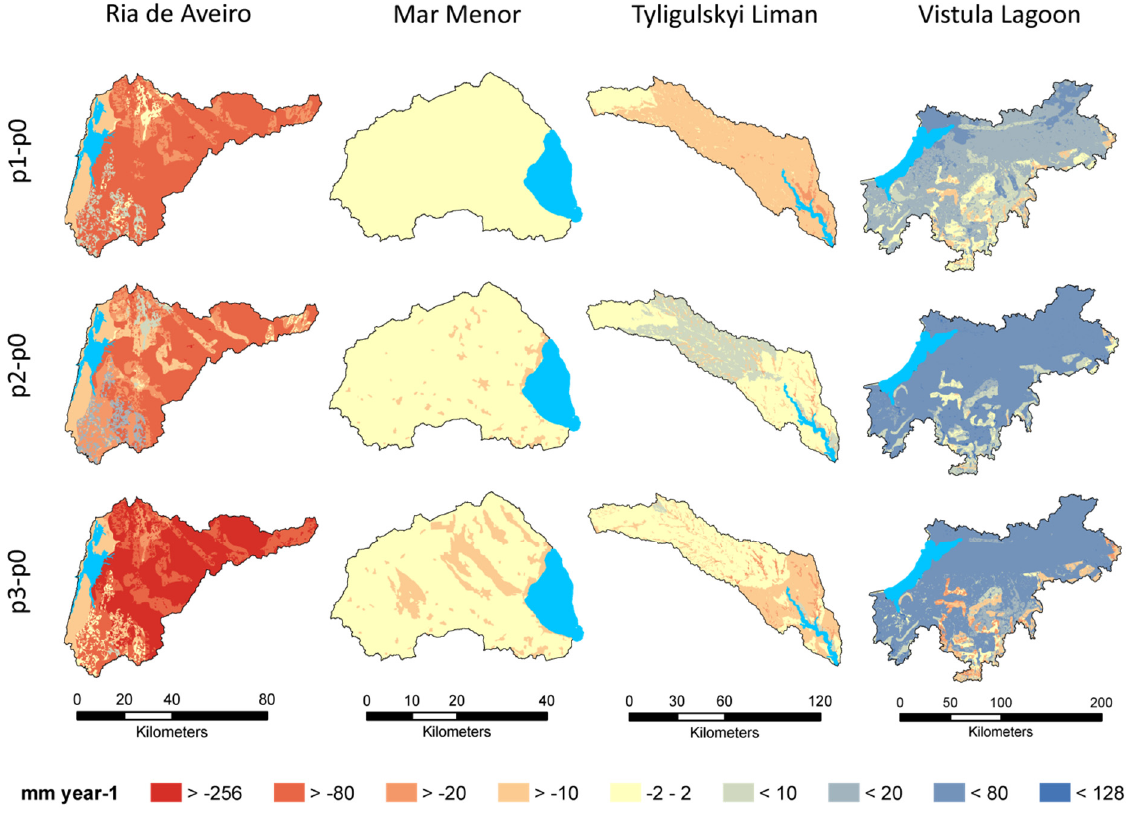
Figure 6. Spatial patterns of average annual changes in runoff (surface and subsurface flow) in the lagoon catchments under study simulated under the set of 15 ENSEMBLES climate change scenarios (average of 15 mean runoff maps for future periods p1, p2, p3 are compared to those of the reference period